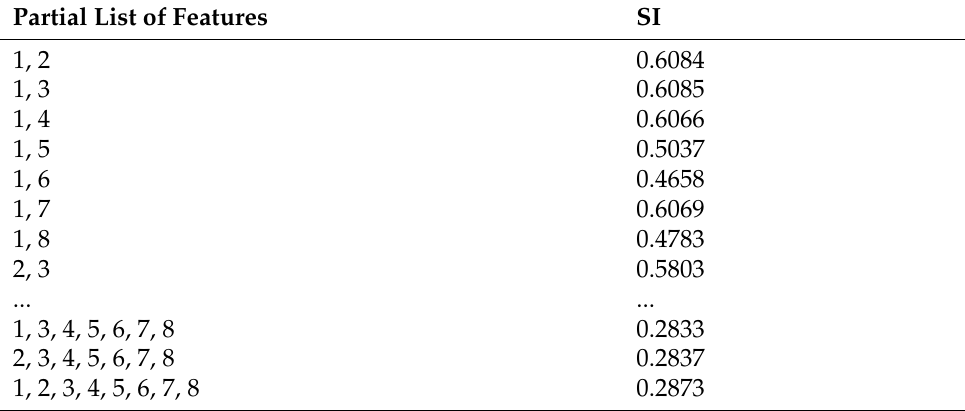
Table 2. Generation of silhouette index for each combination of the